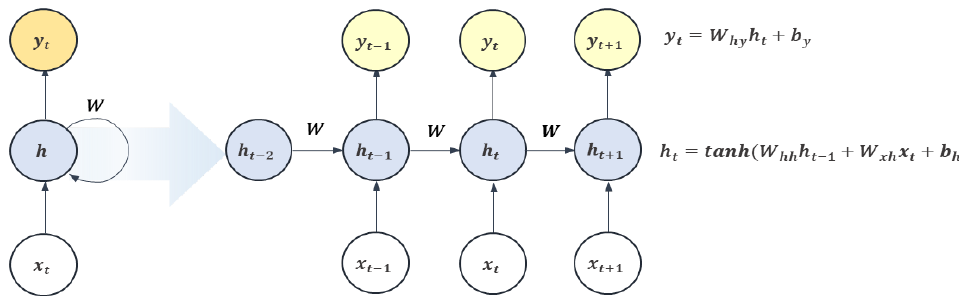
Figure 1. Recurrent neural network.